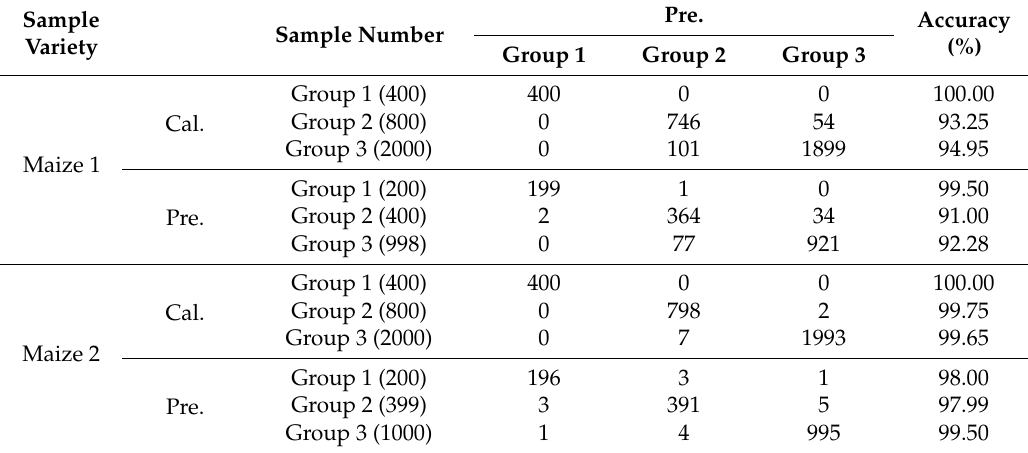
Table 7. The classification accuracy of SVM models of three groups using optimal wavelengths selected by second-order derivative